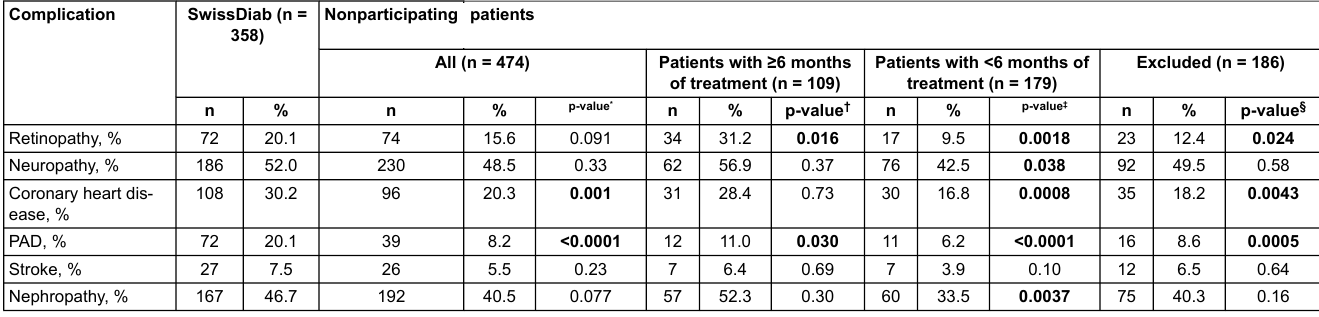
DM2 = diabetes mellitus type 2; PAD = peripheral arterial disease Data are percentages, unless other specified. For the definition of each complication see Method section “Dia- betes-related complications” . * SwissDiab participants vs all nonparticipating patients;† SwissDiab participants vs patients with ≥6 months of treatment at the centre; ‡ SwissDiab participants vs patients with <6 months of treatment at the centre; § SwissDiab participants vs excluded